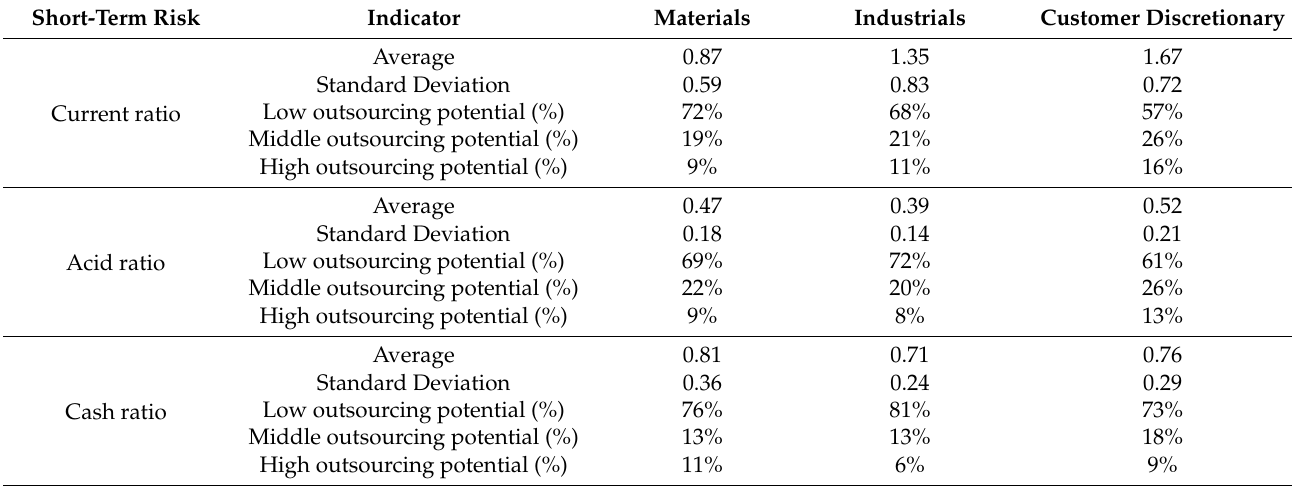
Table 6. Short-term risk results of enterprises included in the